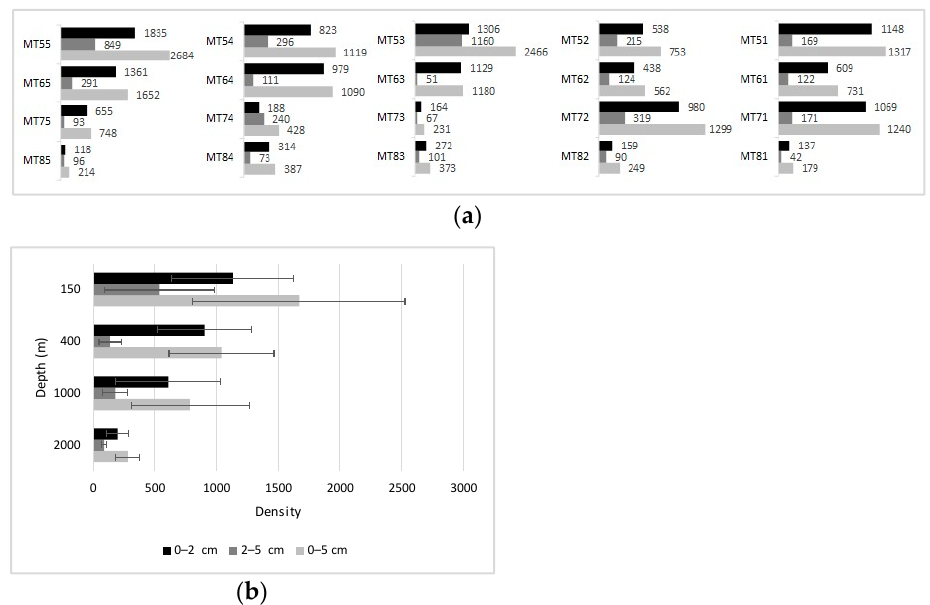
Figure 5. Density of foraminifera. ( a ) Per station at the layers. ( b ) Mean and standard deviation per isobath at the studied layers.